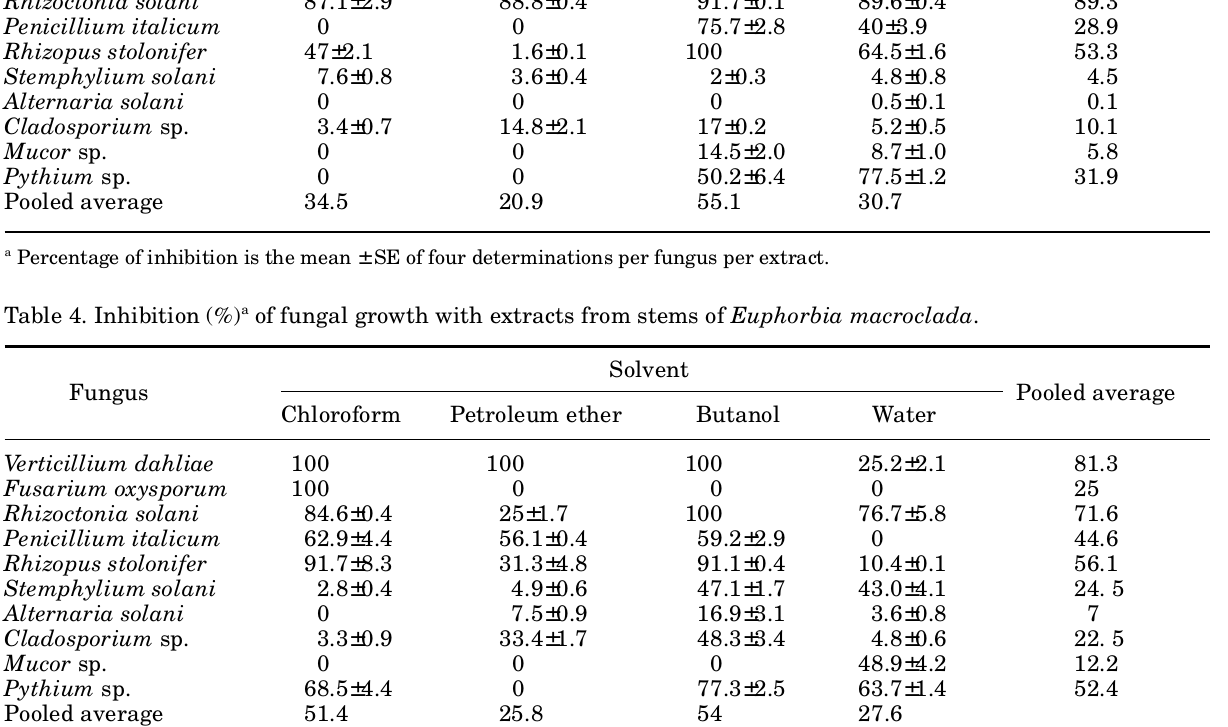
Table 5. Inhibition (%) a of fungal growth with extracts from leaves of Euphorbia macroclada .